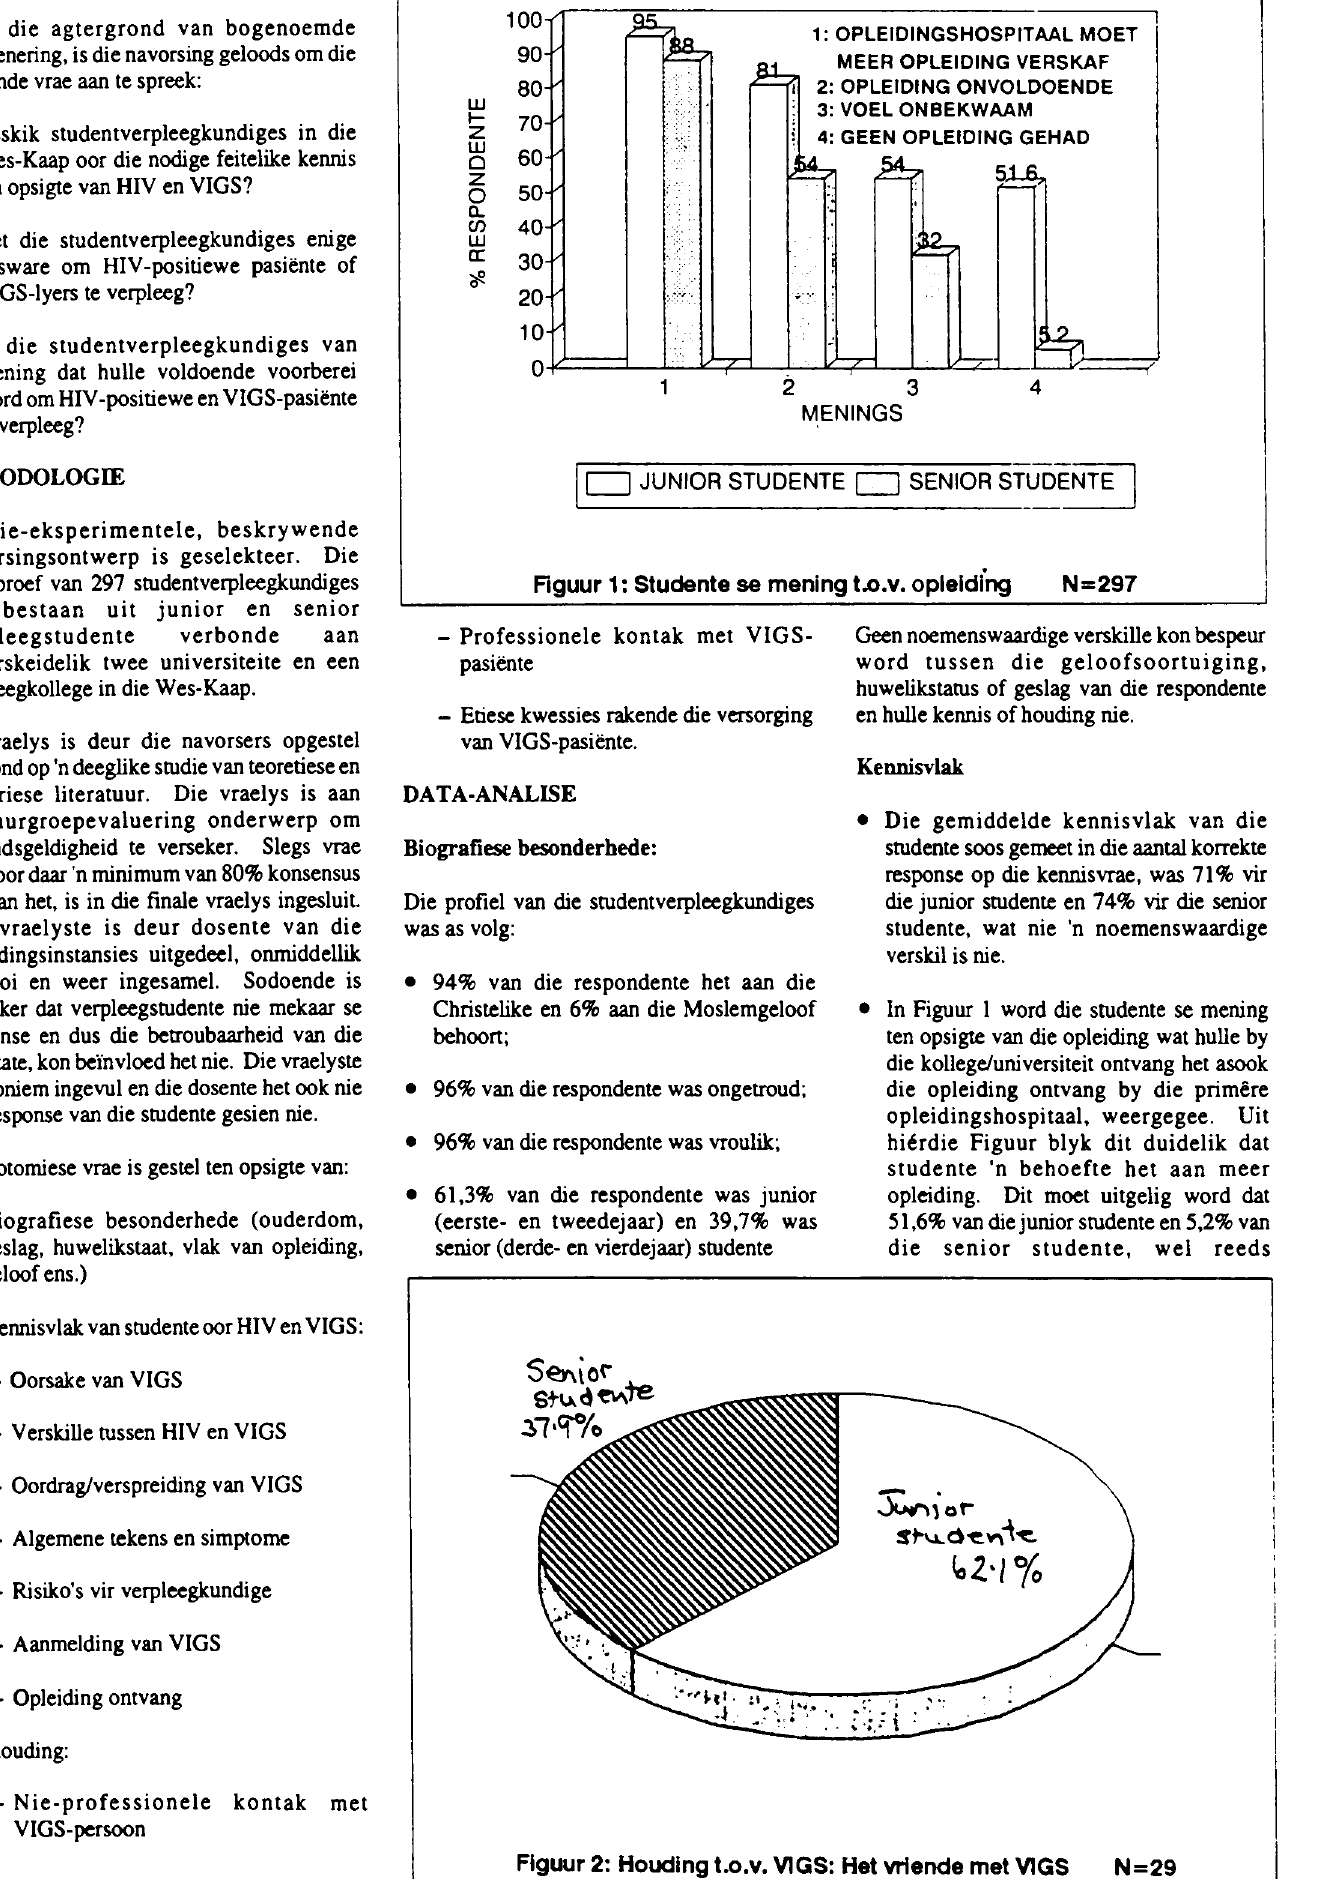
Figuur 2: Houding t.o.v. VIGS: Het vriende met